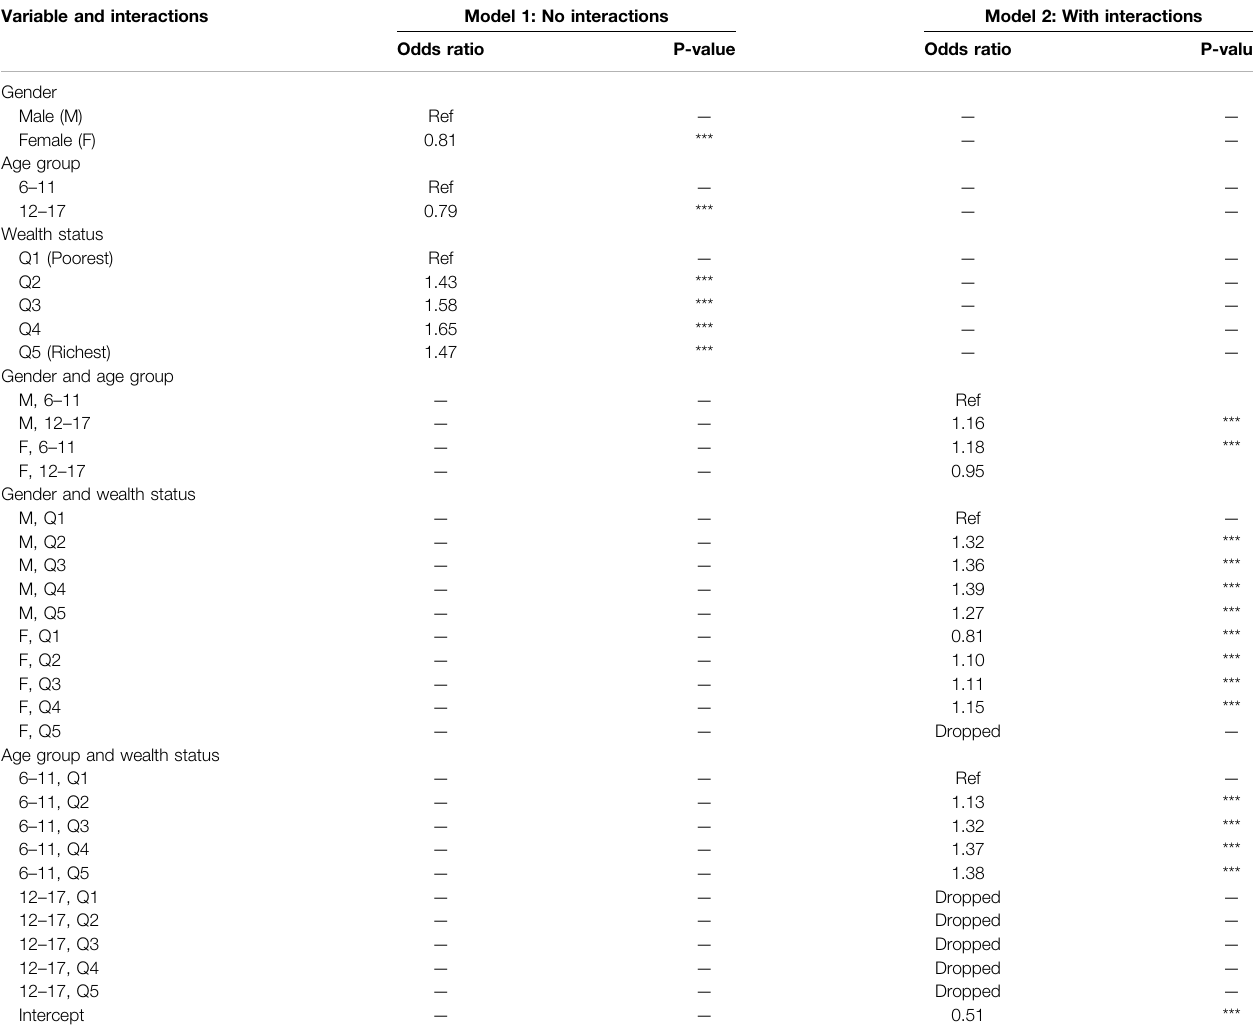
TABLE 6 | Logistic regression models for the effect of wealth and gender on school enrolment in 24 SSA countries. Variable and interactions